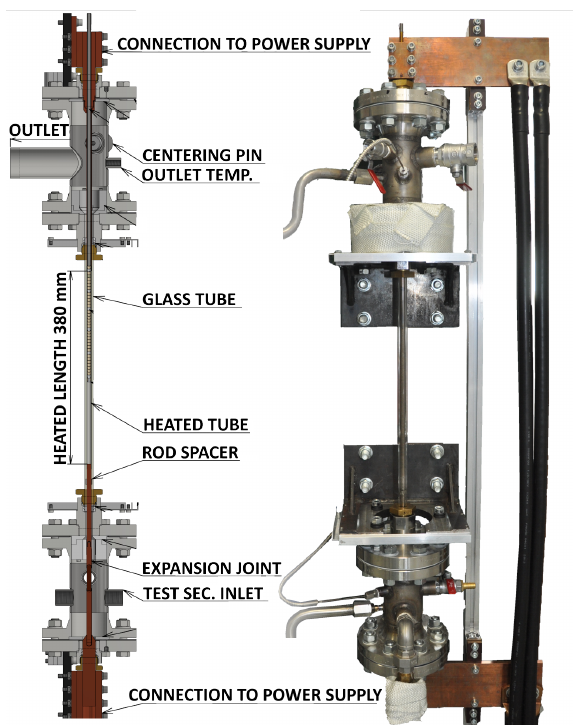
Figure 2. The cross-sectional view of the MRCHA test section with its actual view.